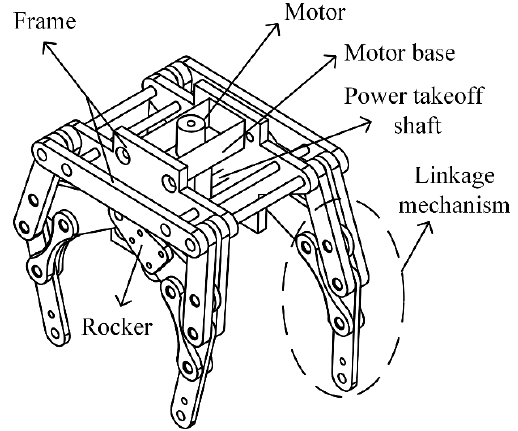
Figure 1. The whole model of the quadruped